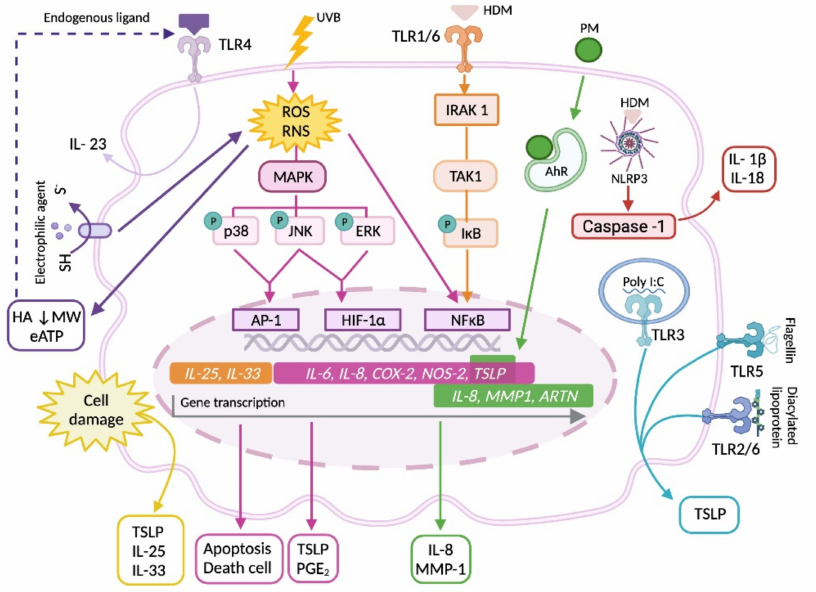
Figure 3. Keratinocyte response to environmental factors. In response to UVB radiation, allergens, endogenous ligands, electrophilic agents, particulate matter present in air pollutants, or ligands of pathogen pattern receptors, KCs activate different signaling pathways that induce apoptosis and cellular death, gene transcription and the release of de novo synthesized type-2 response promoting cytokines and inflammatory mediators, or caspase-1 activation and the subsequent maturation of inflammatory cytokines pro-IL-1 β and pro-IL-18. Abbreviations: AhR, aryl hydrocarbon receptor; COX-2, cyclooxygenase-2; eATP, extracellular ATP; HA, hyaluronic acid; HDM, house dust mite; IL, interleukin; MMP-1, matrix metalloproteinase-1; MW, molecular weight; NOS-2, nitric oxide synthase -2; PGE 2 , prostaglandin E 2 ; TSLP, thymic stromal lymphopoietin. Created with BioRender.com (access date: 26 August